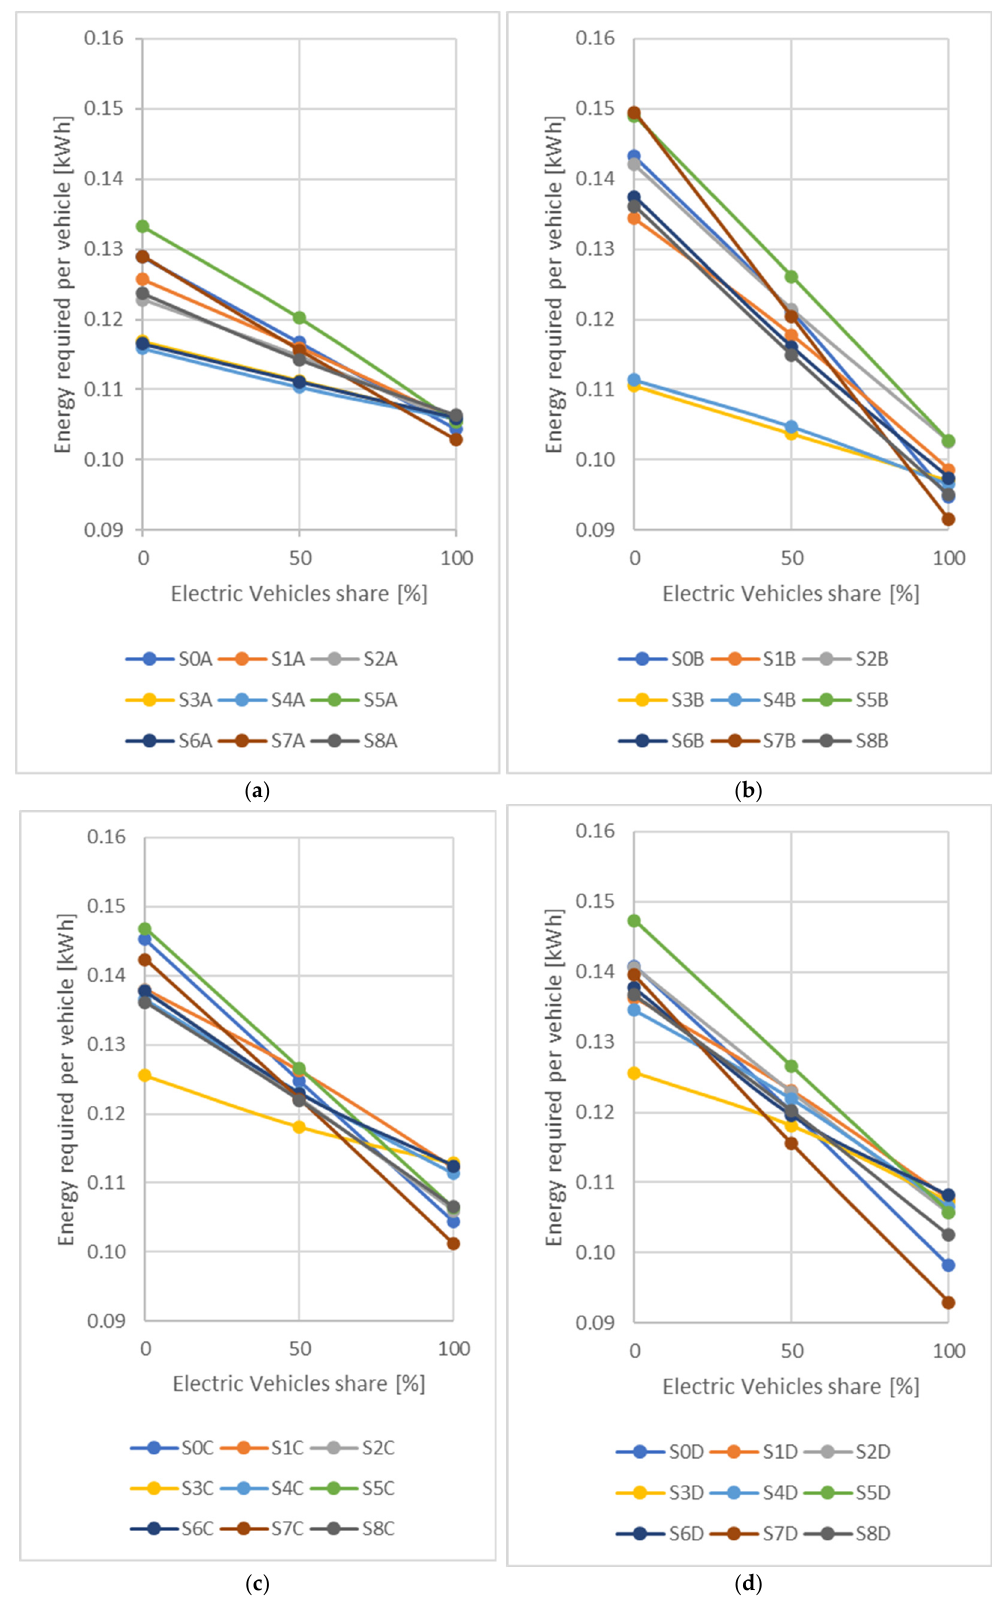
Figure 7. Average energy per vehicle needed to travel through the simulation study area, where ( a – d ) represent the SA–SD transportation demand scenarios.